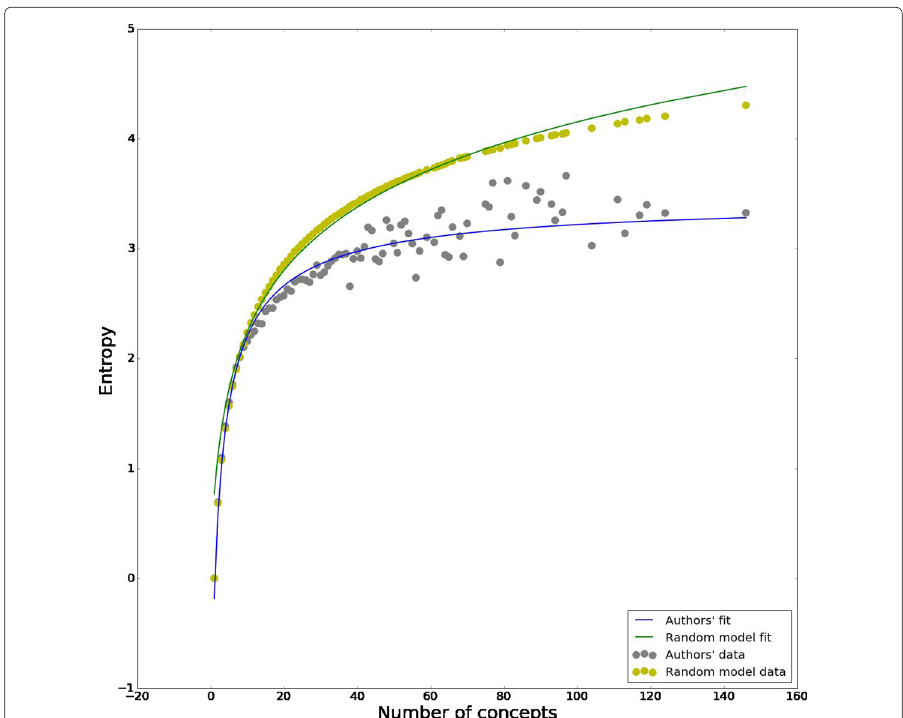
Fig. 13 Authors’ entropy versus null model. Here we compare the entropy for authors in our dataset with average entropy over a null model. Entropy for authors is computed as the average over all authors with k concepts, while entropy for the null model is the average over 1000 random extractions of k concepts from our list. Average entropy for authors is always below the null model, and it is bounded above by a horizontal